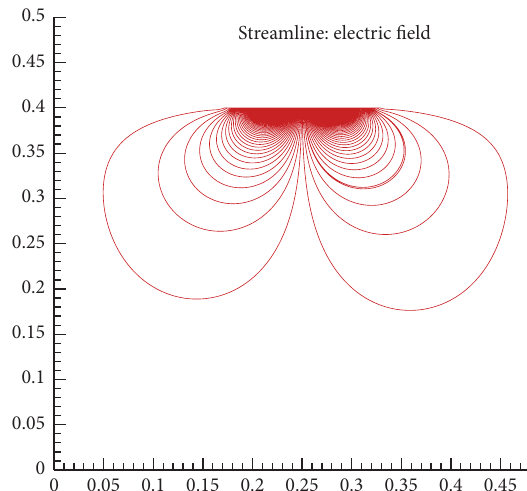
Streamline: electric field